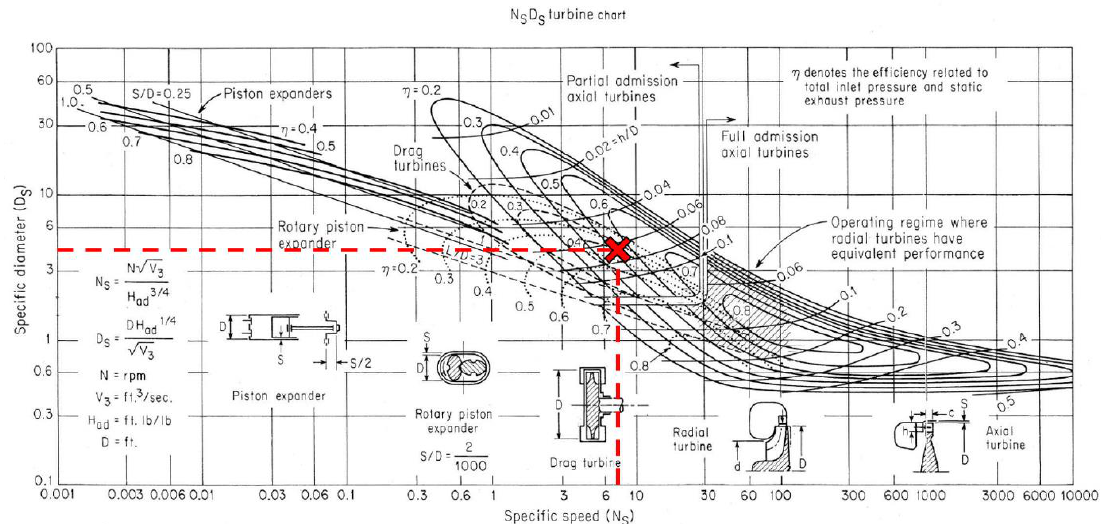
Figure 7. Balje’s diagram including turbine reference conditions (adapted from